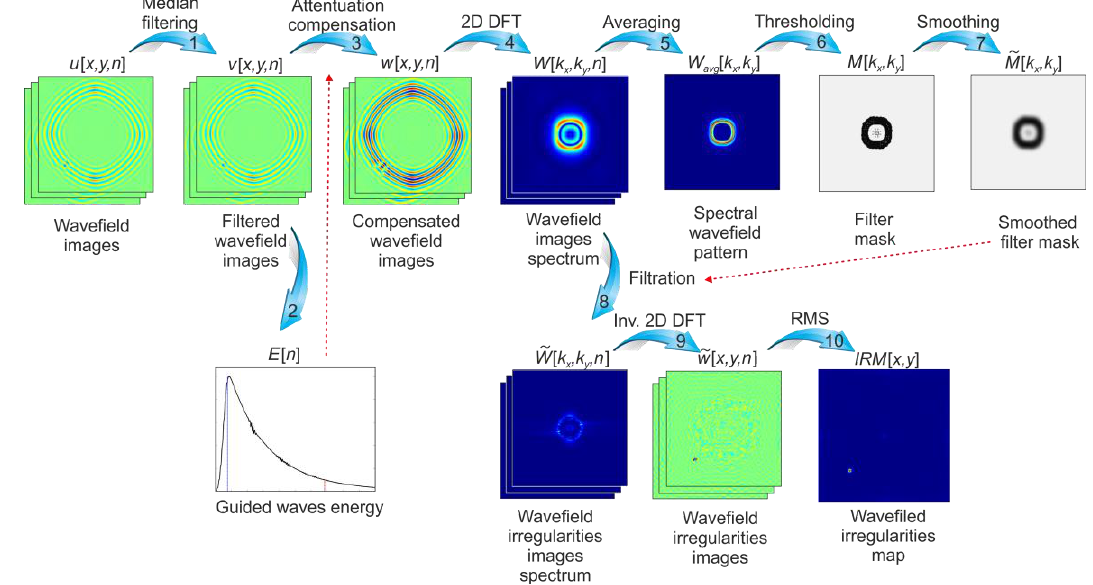
Figure 1. Wavefield irregularities mapping algorithm.